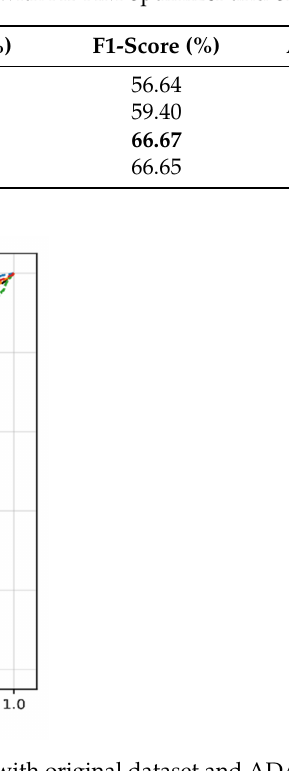
Table 2. Model’s performance for various batch sizes with ADAM optimizer and original dataset.